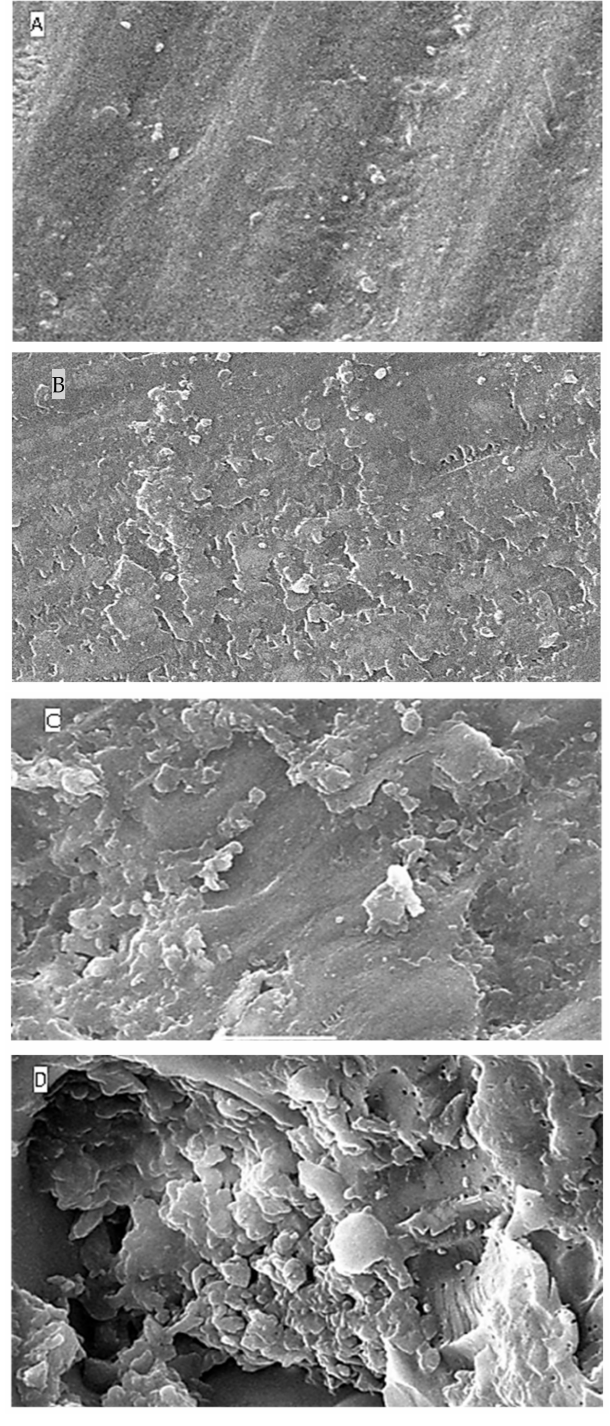
Figure 6. SEM images ( A – D ) of surface roughness at baseline, 24 h, 96 h and 168 h in citrate